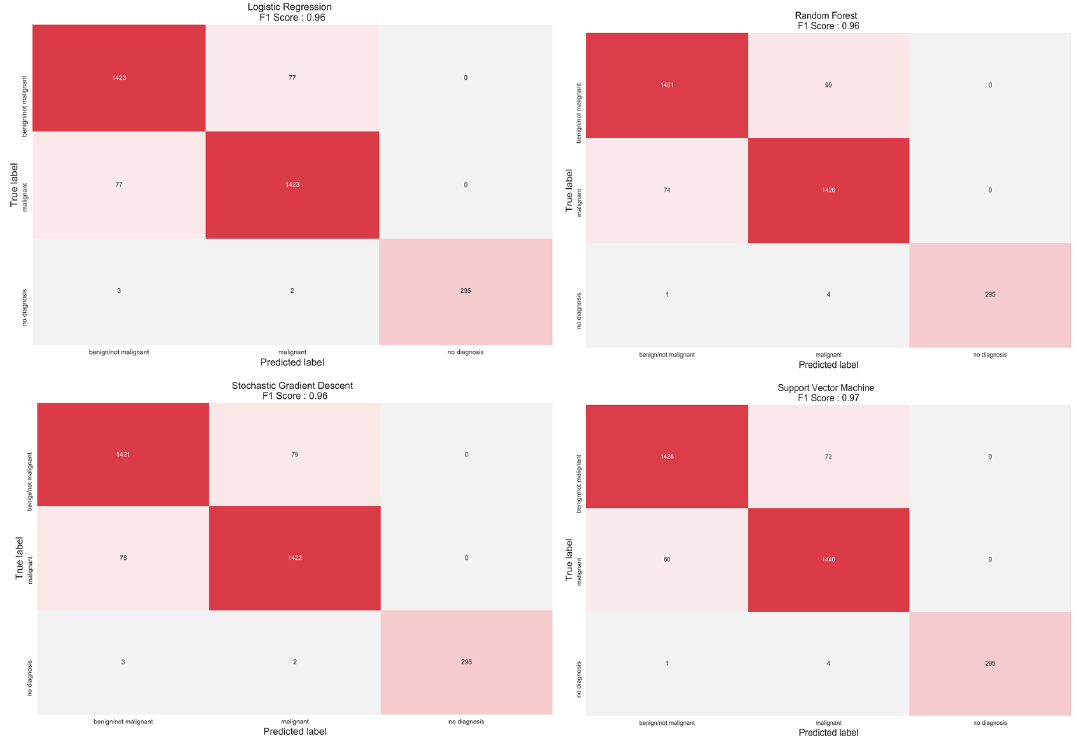
Figure 5. Performance evaluation using the confusion matrix of LR, RF, SGD, and SVM.